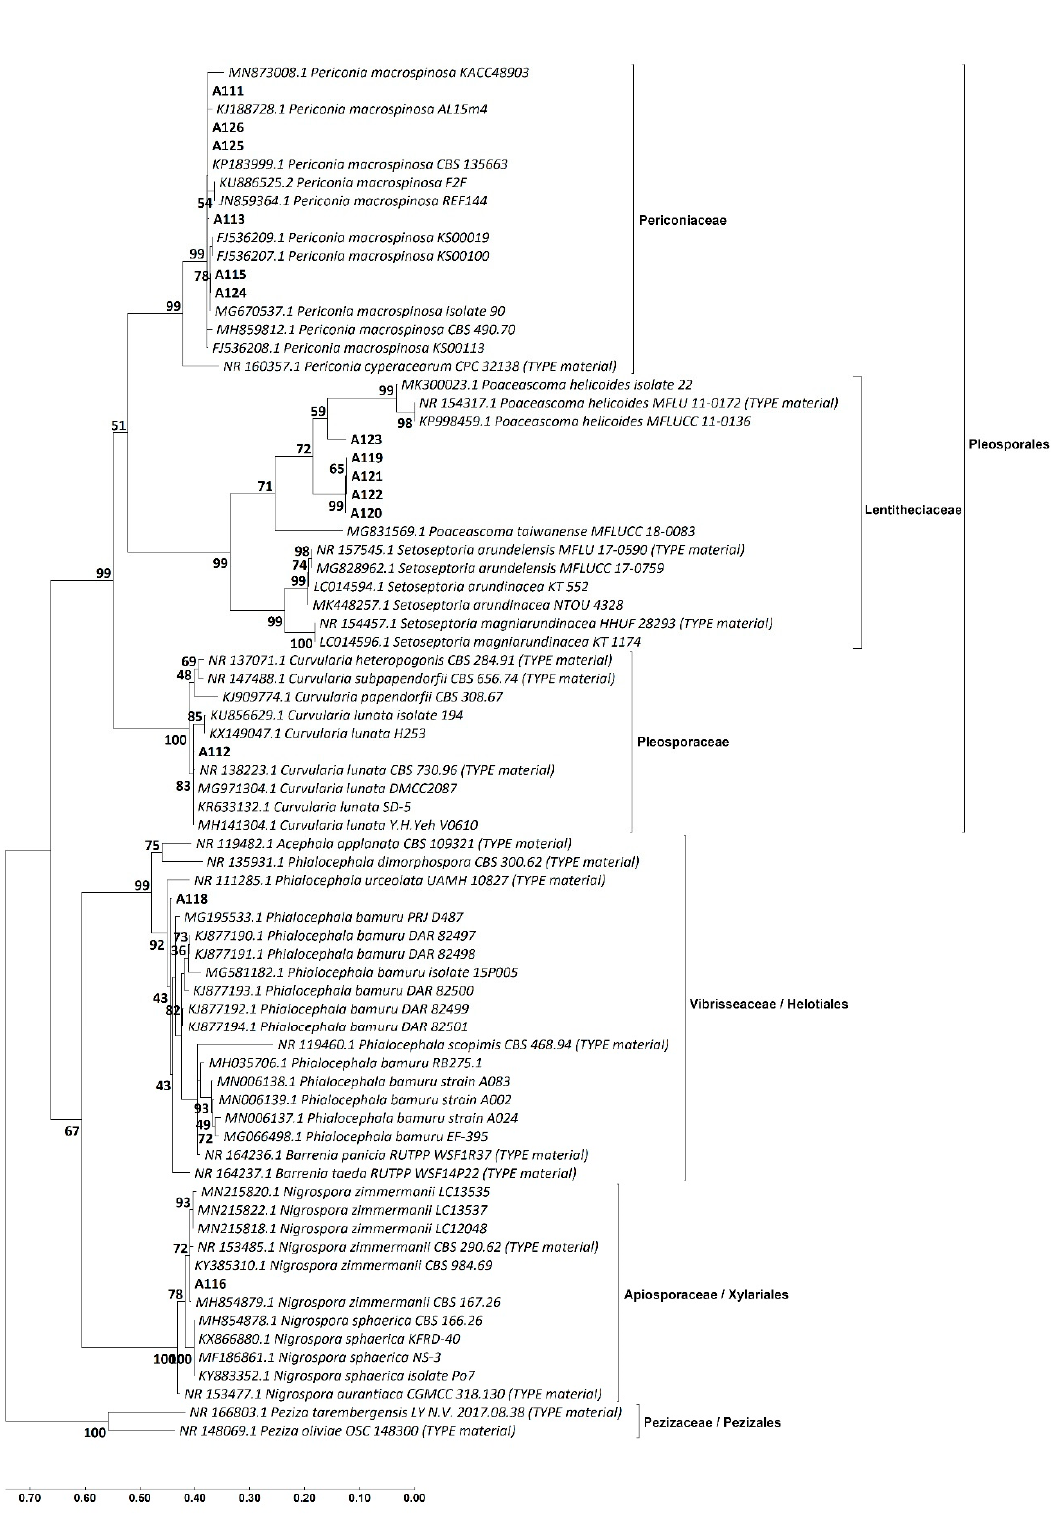
Figure 6. Phylogenetic tree of the internal transcribed spacer (ITS) region of dark septate endophytic fungi isolated from sugarcane roots (in bold) and similar sequences from GenBank. Two Peziza species were added as outgroup references. Tree inferred by the maximum likelihood method and general time reversible model, with the highest log likelihood ( − 10,729.97). Branch lengths analysis involved 75 nucleotide sequences of a total of 2398 positions in the dataset. Numbers next to the branches indicate the percentage of replicate trees in which the associated taxa clustered together (5000 replicates bootstrap test).